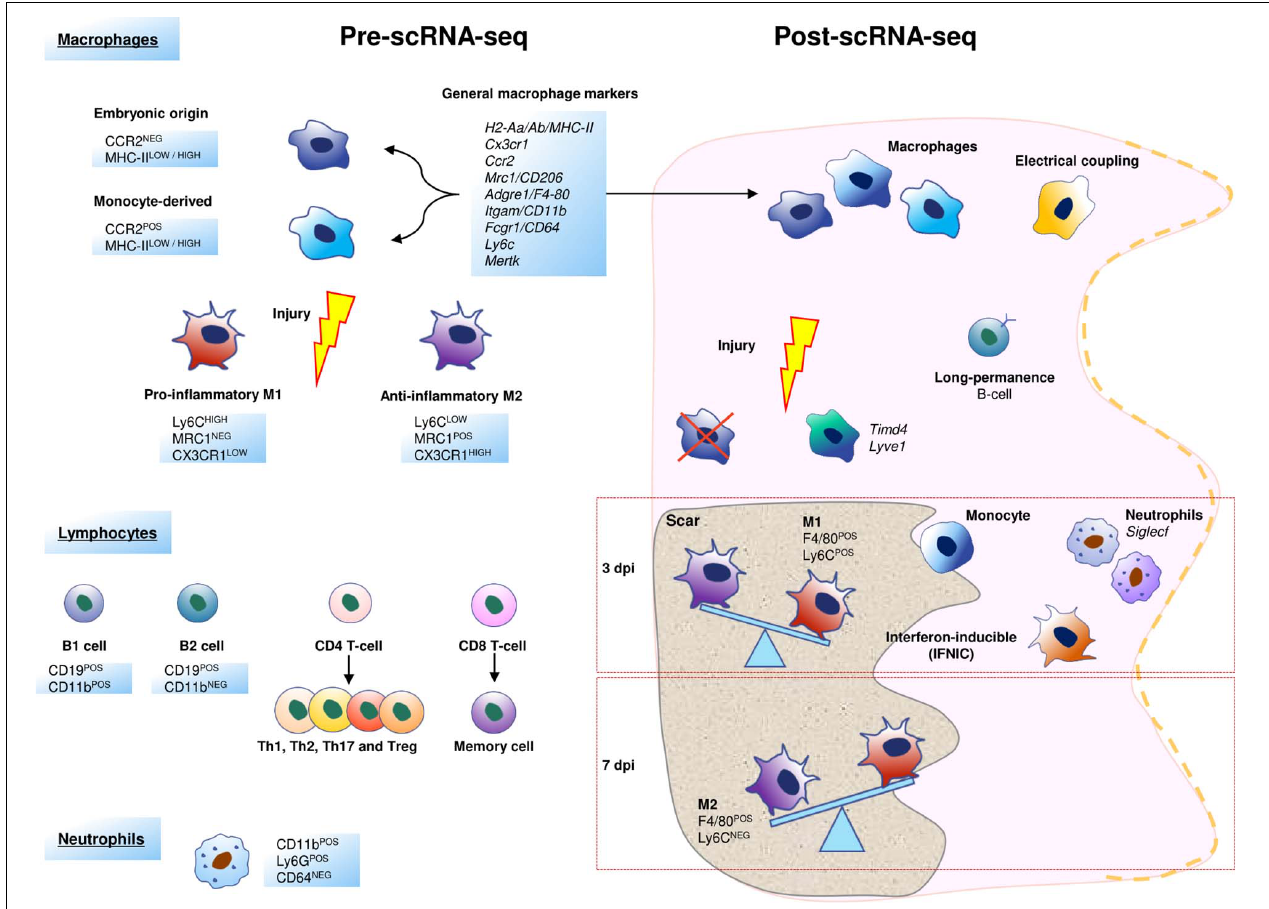
FIGURE 4 | Schematic representation of the cellular heterogeneity of cardiac inflammatory cells before and after scRNA-Seq. In the scRNA-Seq part, each cell represents a cluster characterized by one or more genes, a cell function or other cell aspects. Some of these populations have been named after the original study that identified